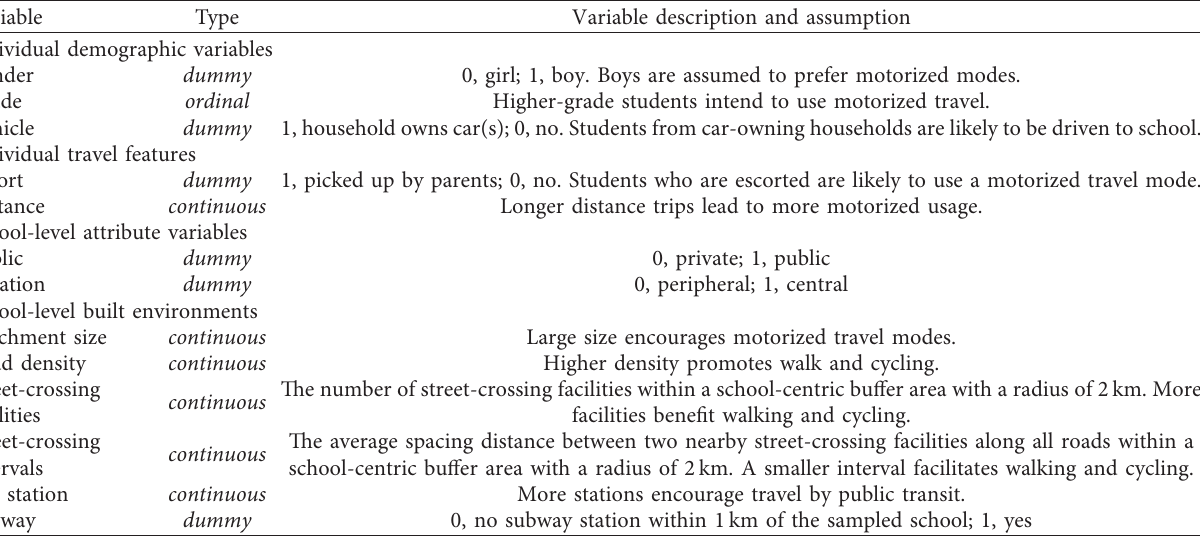
Table 4: Variables used in the model.